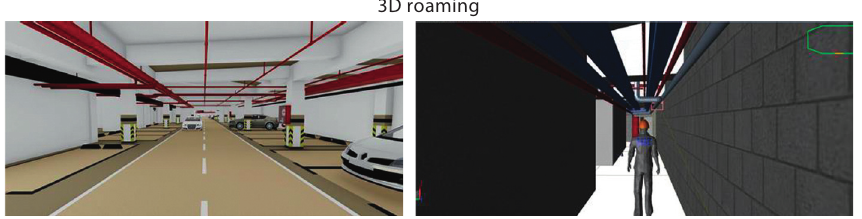
Figure 16: 3D roaming in BIM